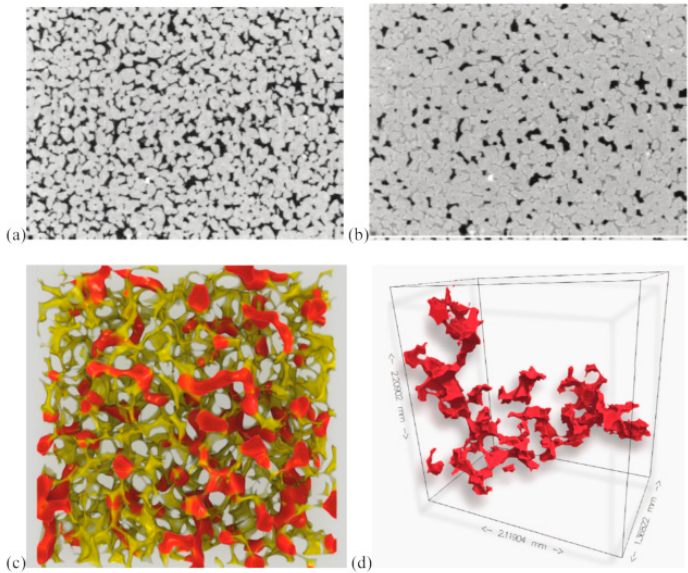
Figure 7. µCT images (2D and 3D) for a spontaneous imbibition (SI) in a strongly water-wet saturated with gas. ( a ) cross-section of a dry Fontainebleau sample, ( b ) the same cross-section after SI, ( c ) 3D visualization of a small sub-section of the 3D volume at residual gas saturation; the yellow shows the pore structure and red the trapped gas phase. ( d ) a 3D rendered image of a single large gas residual blob. (Reprinted with permission from Kumar et al.[295]).